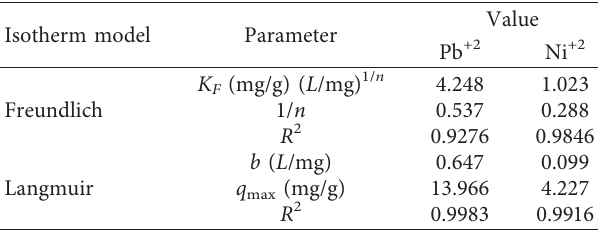
Figure 3: Removal efficiencies of Pb +2 and Ni +2 ions onto WFS at different values of (a) sorbent dosage, (b) initial concentration, and (c) agitation speed as well as (d) Langmuir isotherm model for sorption data. Table 2: Constants of isotherm models with statistical measures for sorption of Pb +2 and Ni +2 ions onto WFS (time � 60min, pH � 4 (Pb +2 ) and 6 (Ni +2 ), dosage � 2.5g/100 mL, and agitation speed �